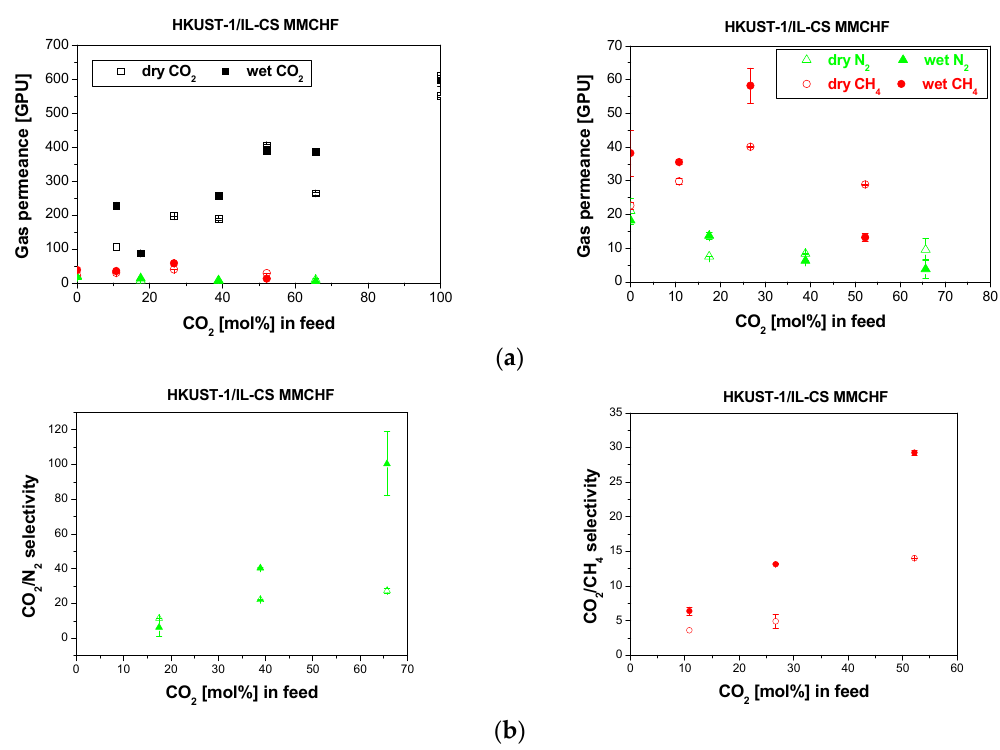
Figure 6. Gas permeance ( a ) and selectivity ( b ) obtained for the separation of CO 2 /N 2 (left) and CO 2 /CH 4 (right) mixtures through the HKUST ‐ 1/IL ‐ CS/PSf MMCHF membrane in dry (void symbols) and wet (full symbols). The right side of figure ( a ) shows the trend in the slow gas (N 2 , CH 4 )